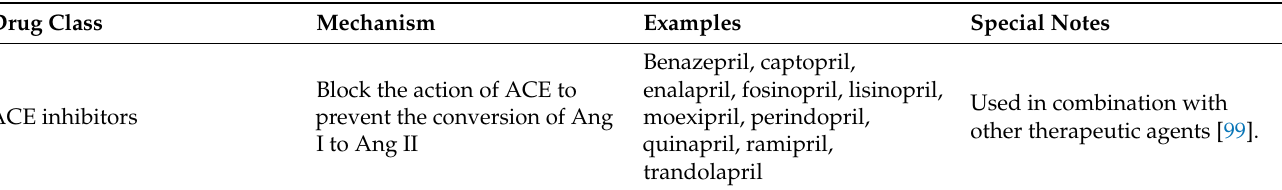
Table 1. Current antihypertensive medications in clinical